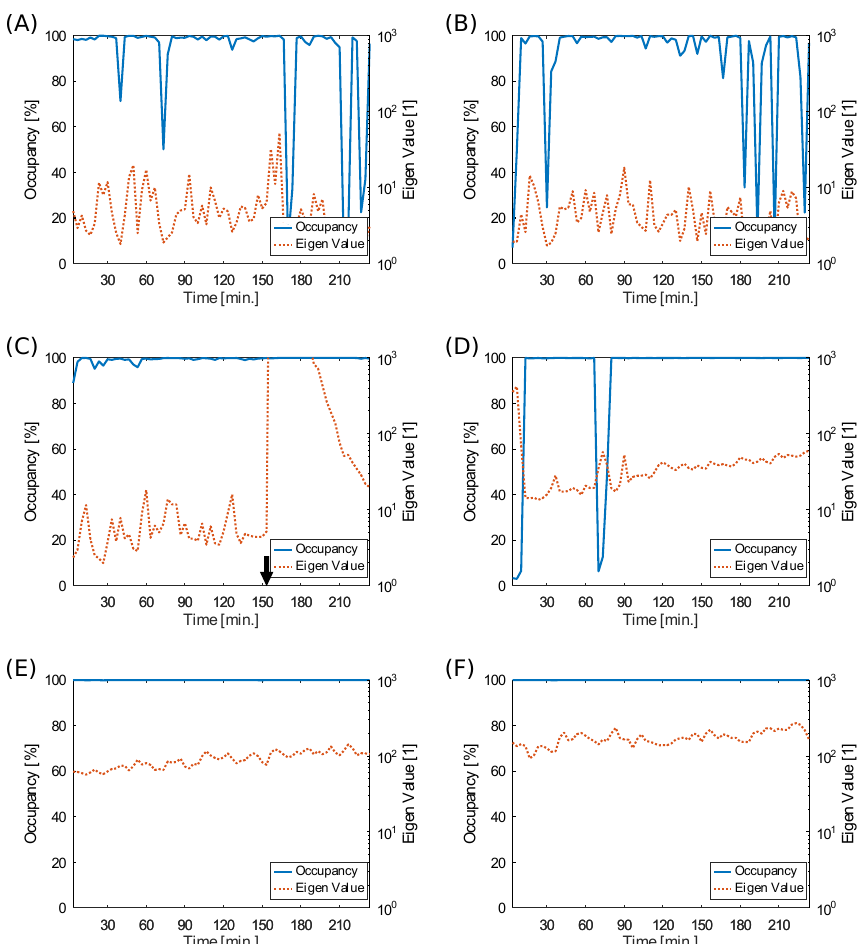
Figure 7. Occupancy rate and the first eigenvalue around the Mie earthquake for ( A ) 2016/091/16-19, ( B ) 2016/091/20-24, ( C ) 2016/092/00-04, ( D ) 2016/92/04-08, ( E ) 2016/92/08-12, ( F ) 2016/92/12-16. The down arrow shows the time the earthquake